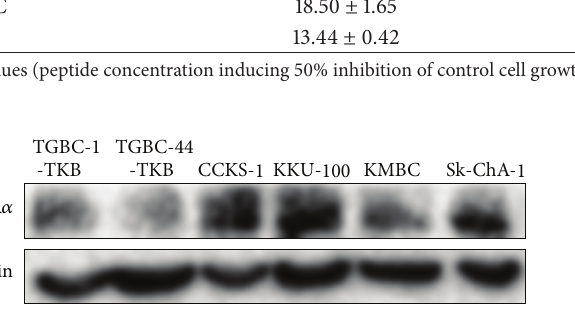
Figure 1: Expression levels of IL-4R 𝛼 in BTC cells. Cell lysates were prepared from six BTC cell lines. 𝛽 -Actin was used as an internal control.